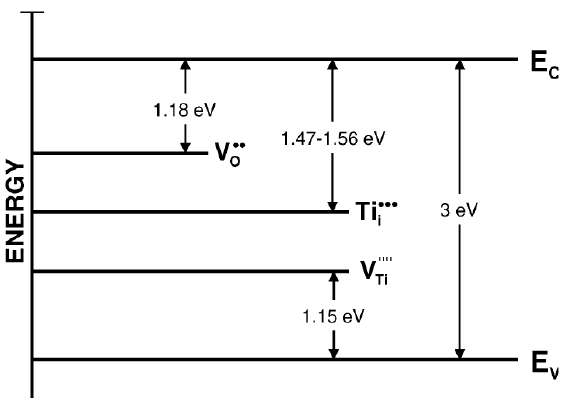
Figure 2. Band model of TiO 2 with the indication of the energy levels of intrinsic lattice defects: oxygen vacancies, titanium interstitials and titanium vacancies. Reprinted with permission from [26]. Copyright 2008, American Chemical Society.